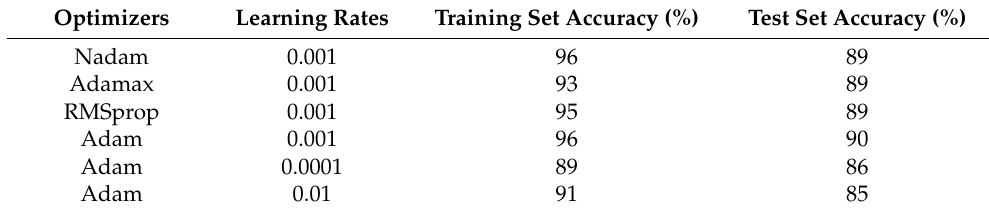
Table 3. Relationship between optimizers, learning rates, the training set accuracy, and test set accuracy